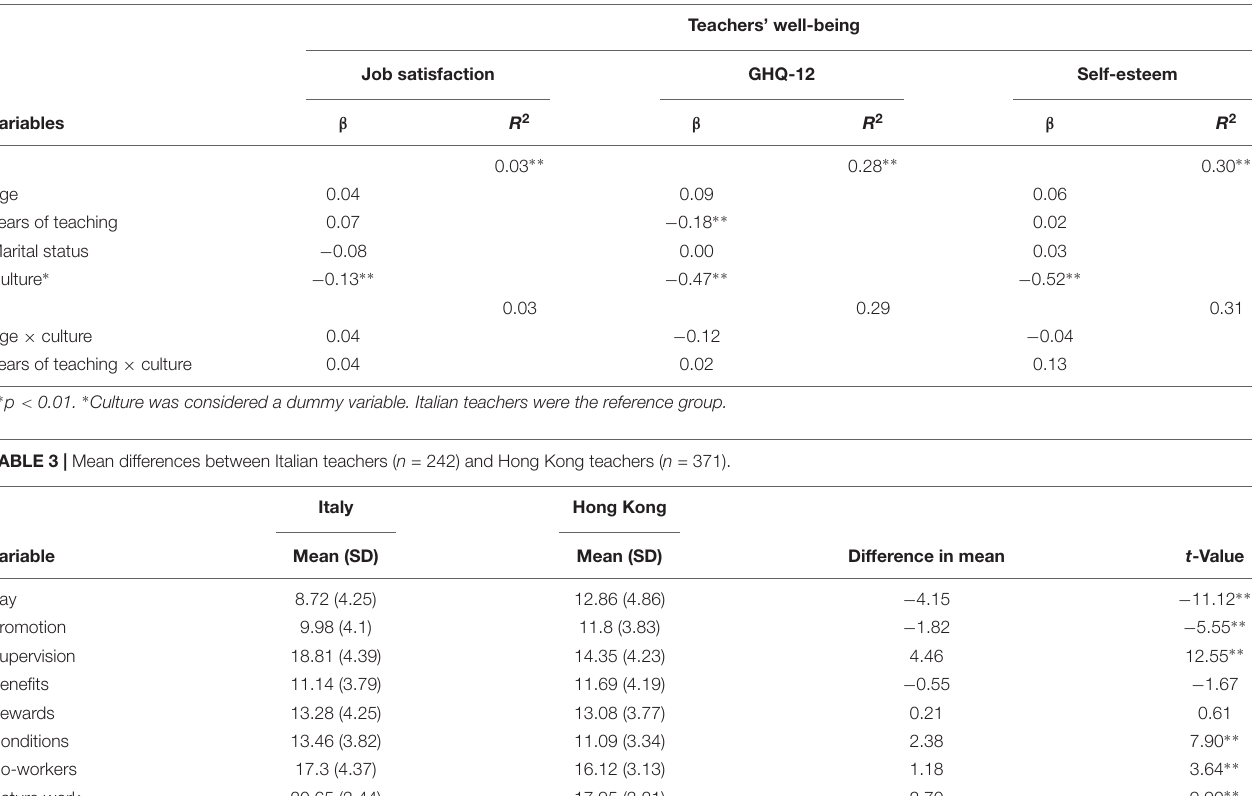
TABLE 2 | Multiple regression